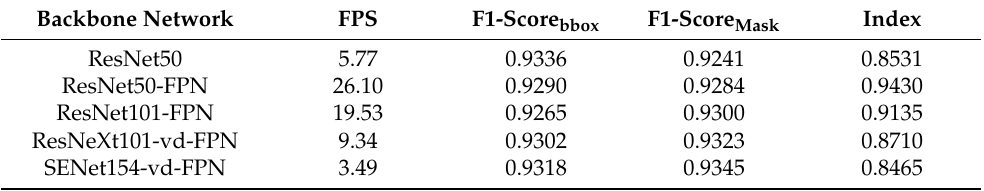
Table 1. Evaluation index values for mature green tomato dataset under different backbone